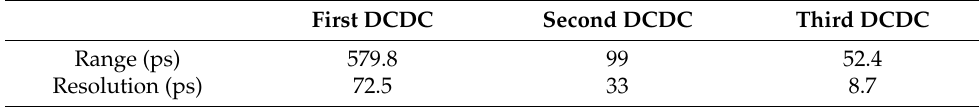
Table 1. Controllable delay range and resolution of each